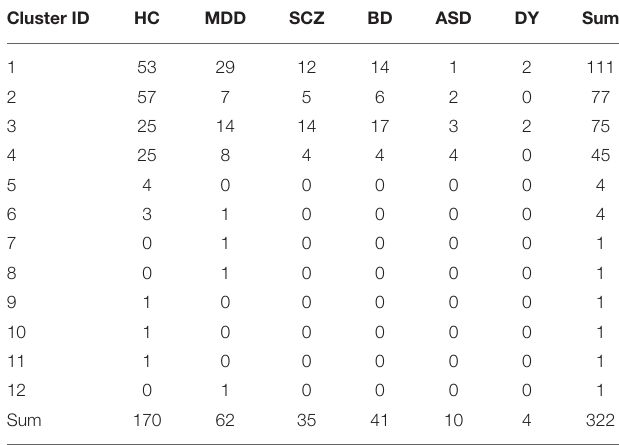
TABLE 4 | Distribution of psychiatric disorders of UTO data for clusters in view